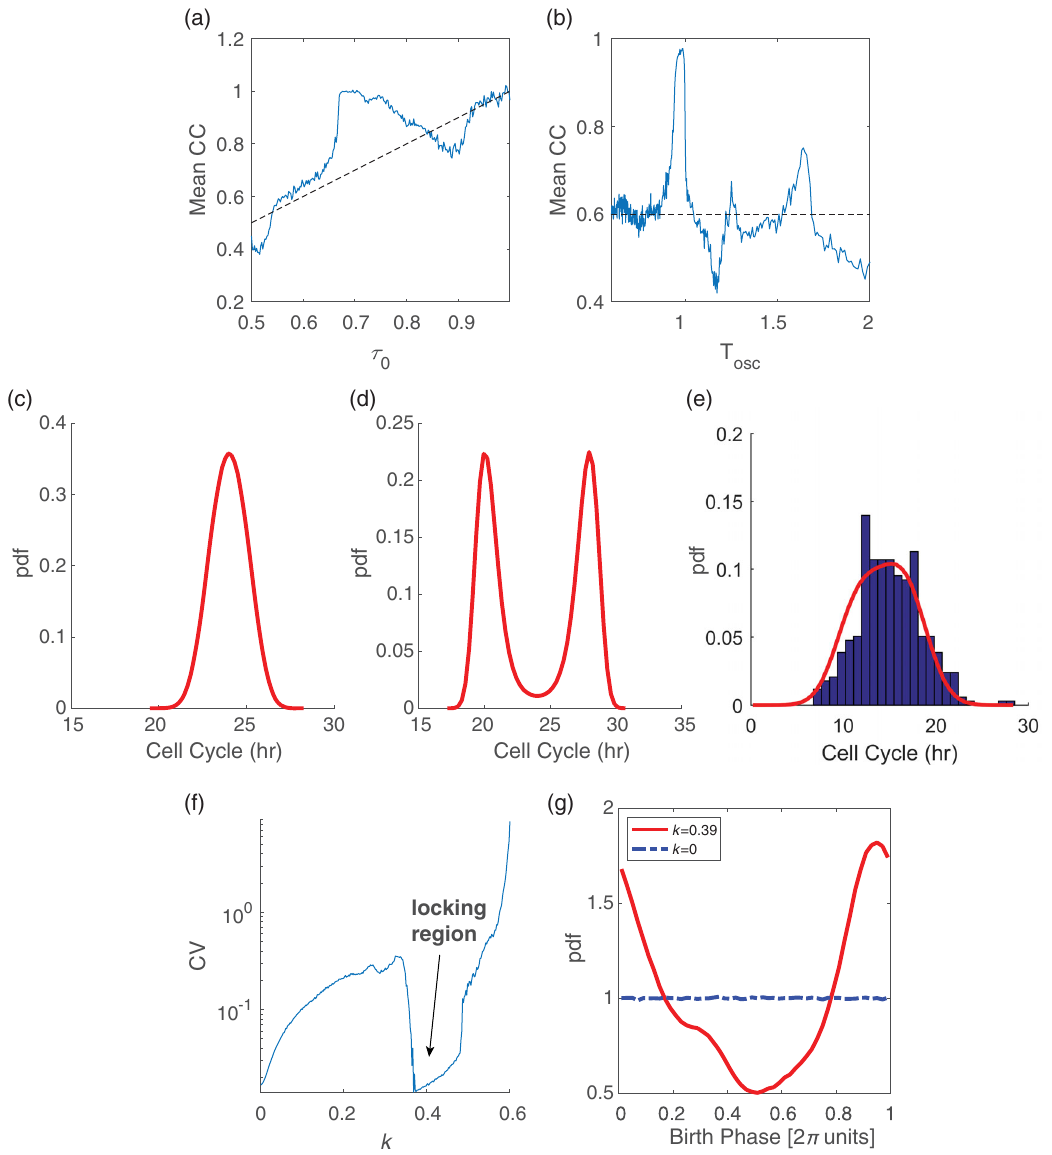
FIG. 9. Prediction of the kicked cell-cycle model. (a),(b) Nonmonotonous dependence of the mean cell-cycle duration ¼ 1 (accordingly, all times are in T versus different parameters. In both panels, α ¼ − 0 . 5 and ξ ¼ 0 . 01 . (a) T units); osc osc k ¼ 0 . 5 ; and τ τ τ 0 is varied. The dashed line is the line where the mean cell-cycle equals 0 . Paradoxically, changing 0 from 0.7 to 0.9 (for example, by lowering the nutrients ’ concentration) can result in faster mean growth. (b) k ¼ 0 . 6 , τ 0 ¼ 0 . 6 (the dashed line represents the value of τ 0 , and T is changing). (c),(d) Examples for cell-cycle duration distributions predicted by osc ¼ 24 h, k ¼ 0 . 4 , α ¼ 0 . 2 , ξ ¼ 0 . 01 . ξ , k , and τ T the model for different parameters. In both panels, T units. 0 are in osc osc τ ¼ 0 . 8 (c) or τ ¼ 1 (d). (e) Distributions of the cell-cycle duration of experiment Cyanobacteria 2, with data (blue bars) and 0 0 model predictions (red lines). (f) Cell-cycle duration CV versus k as predicted from the model, with α ¼ 0 . 2 , τ 0 ¼ 0 . 6 , and ξ ¼ 0 . 01 . Note that the CV (and hence the variability) is increasing or decreasing for different k ’ s. (g) Birth phase distribution as predicted from the model for the parameters obtained from the fit to Cyanobacteria 1 (Table 2) in the red line, and for the same parameters but with k ¼ 0 (blue dashed